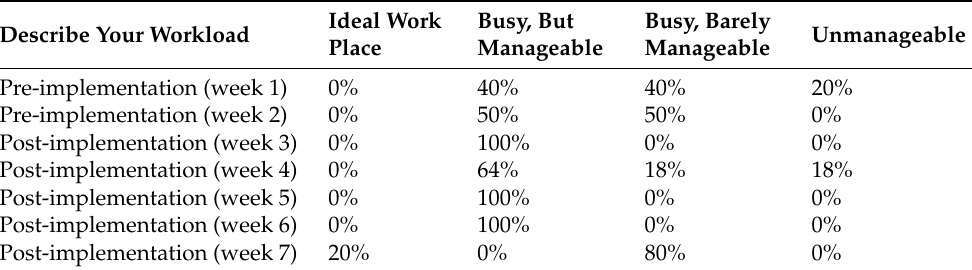
Table 2. Workload Survey.